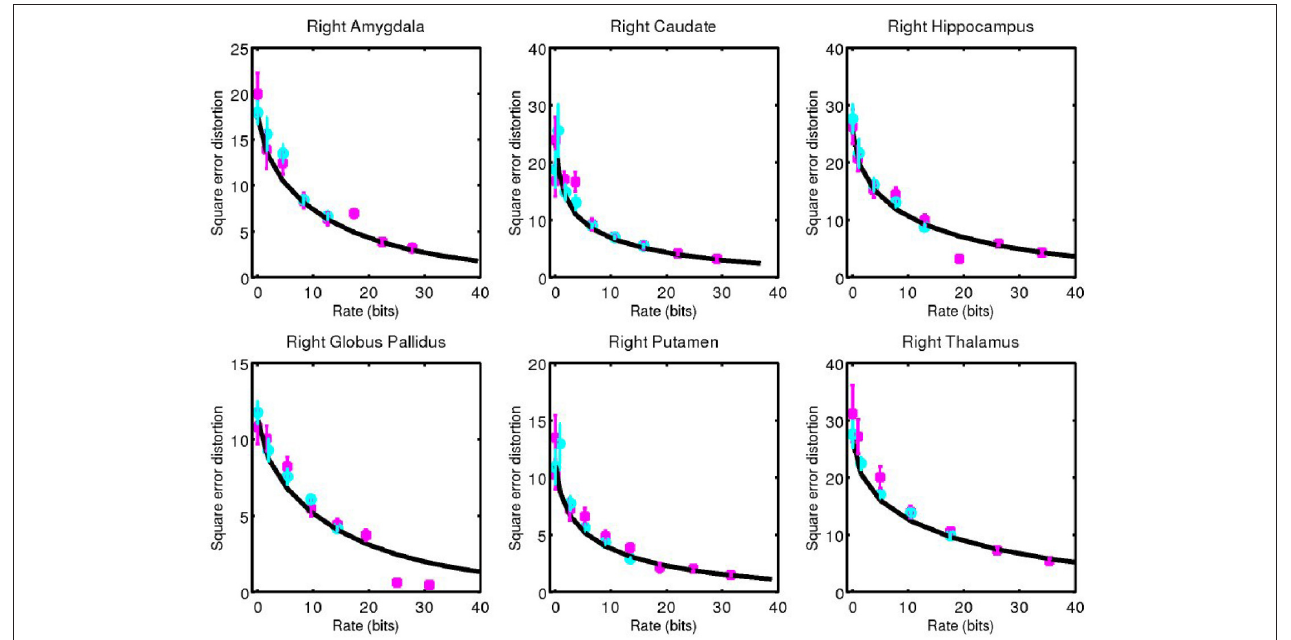
FIGURE 6 | Corresponding data from Figure 5 for right side structures.